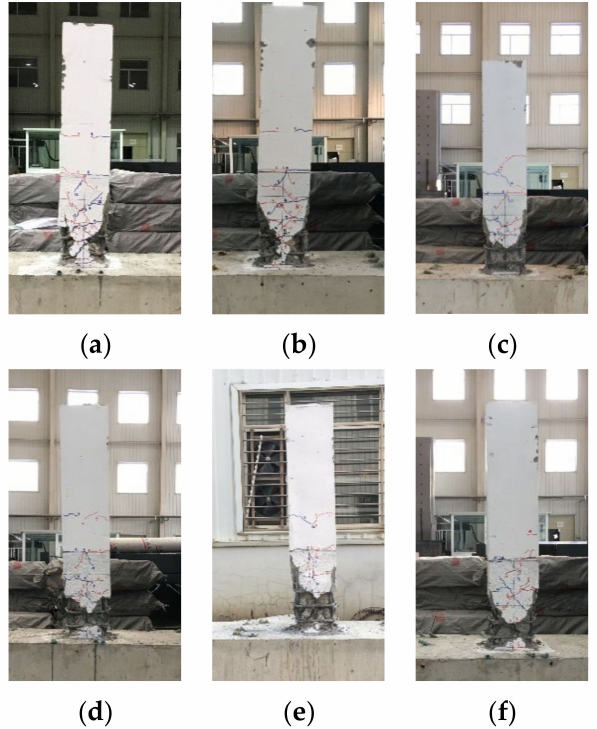
Figure 23. The failure mode of the specimens. ( a ) JP-F0. ( b ) JP-F1. ( c ) JP-F2. ( d ) JP-F3. ( e ) JP-F4. ( f )